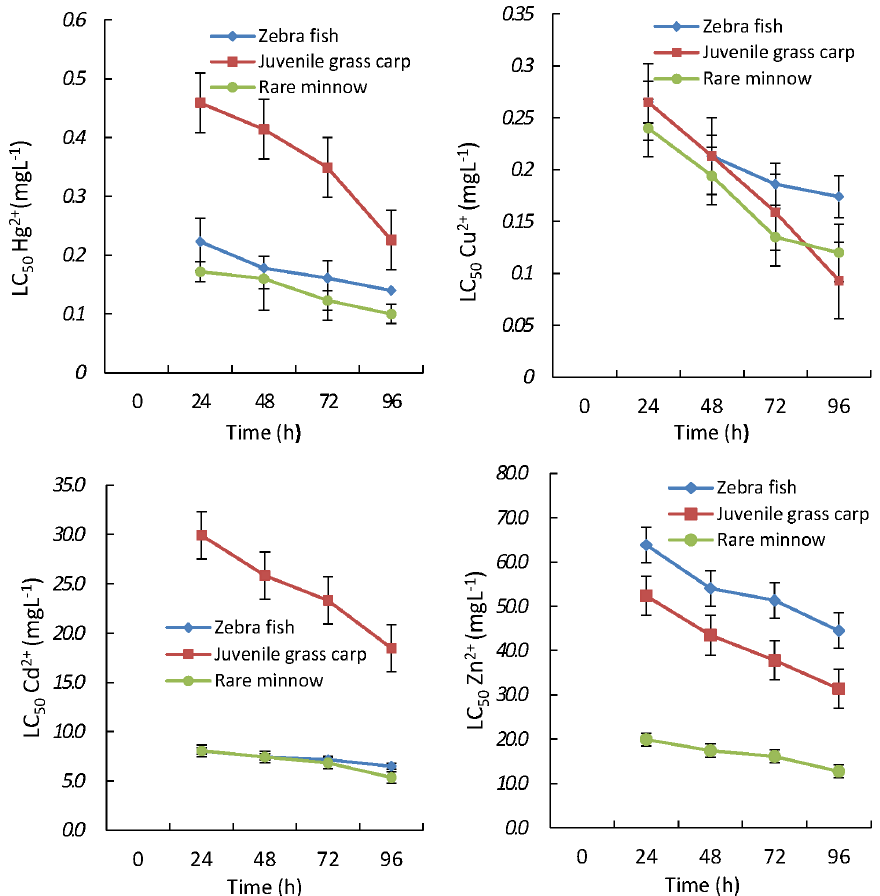
Figure 1. LC 50 values (mgL 2 1 ) over time for zebrafish ( Brachydaniorerio) , rare Minnow (Gobiocyprisrarus) and juvenile grass carp (Ctenopharyngodonidellus) exposed to 4 kinds of heavy metals.